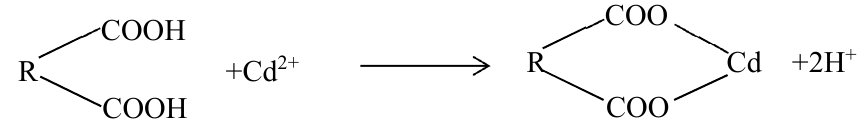
Figure 7. Sorbtion mechanism by which some functional group such as COOH complex with Cd2+ to immobilize it in soil. Table 2. Influences of modified and unmodified rice straw on soil physical and chemical properties. Treatment